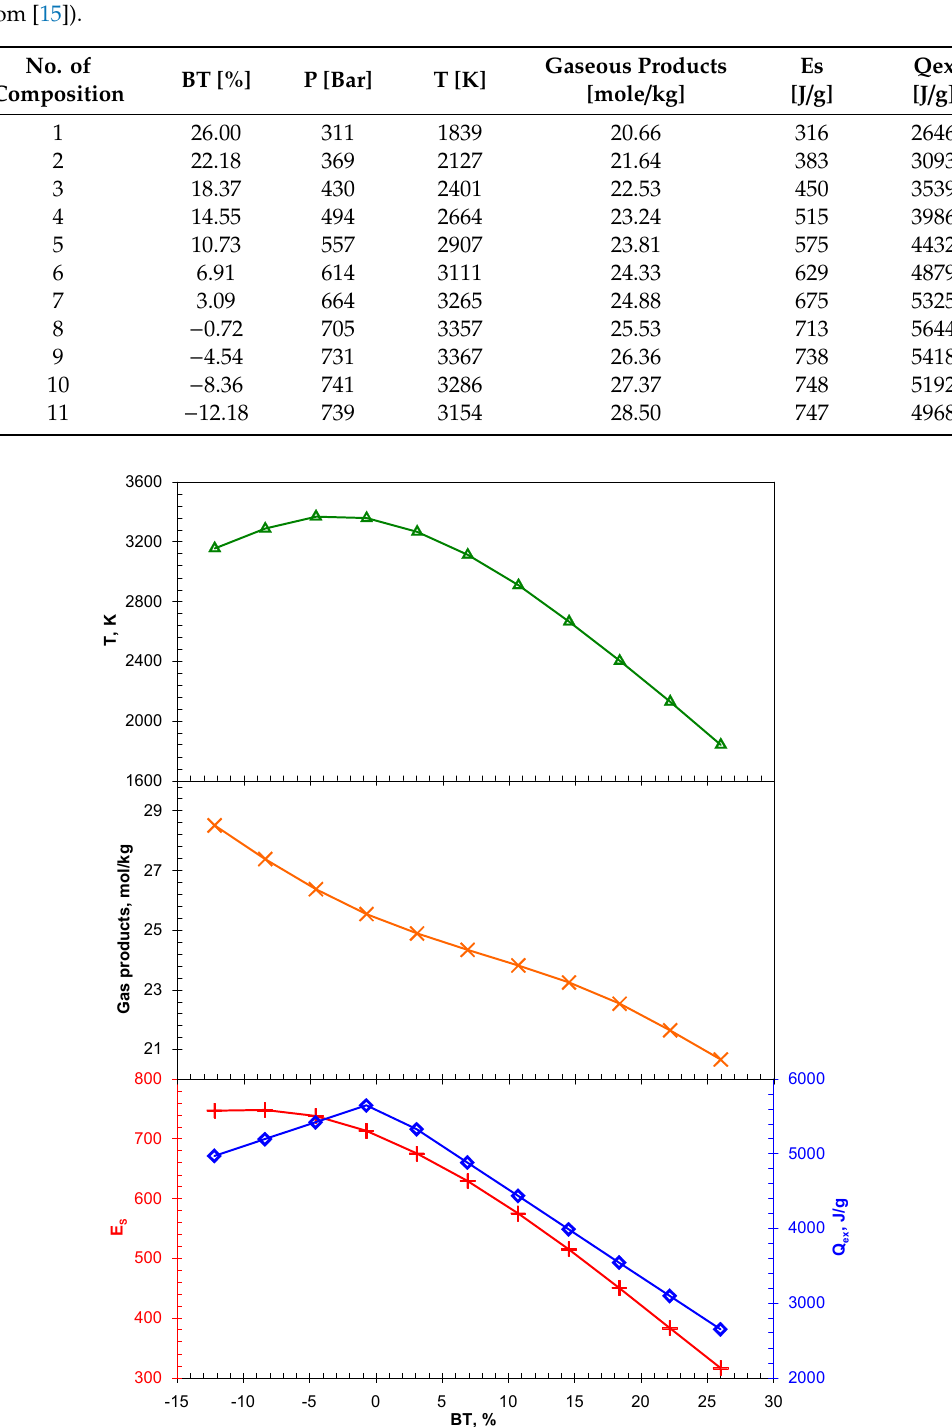
Figure 1. Relationship between thermodynamic parameters of tested mixtures and oxygen balance.